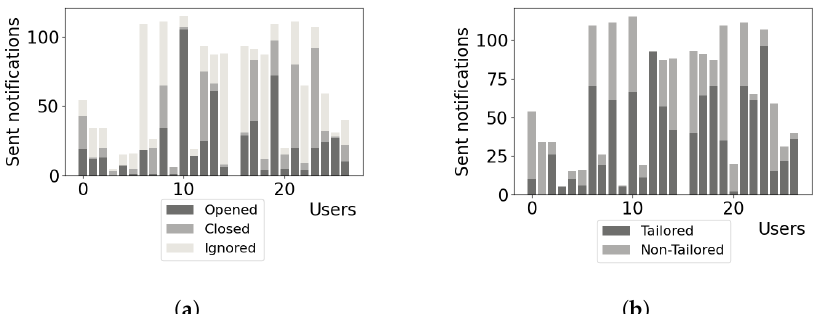
Figure 2. Notification action and tailored/non-tailored notification distribution. ( a ) denotes the distribution of reactions to notifications delivered, ( b ) denotes the proportion of TN delivered to